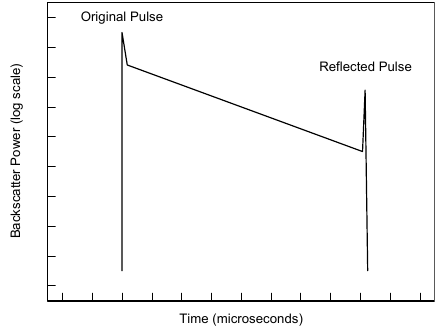
Figure 5. Typical plot of the backscattered power as a function of